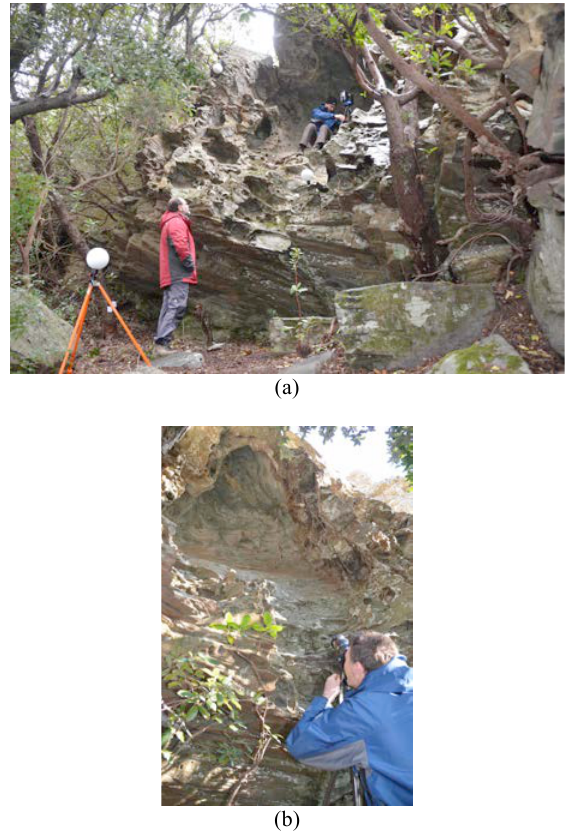
Figure 2. (a) Faro Focus 3D set up in the upper part of the rock-shelter; (b) photogrammetric recording at 7 m from the top of the dome (photos A. Burens)